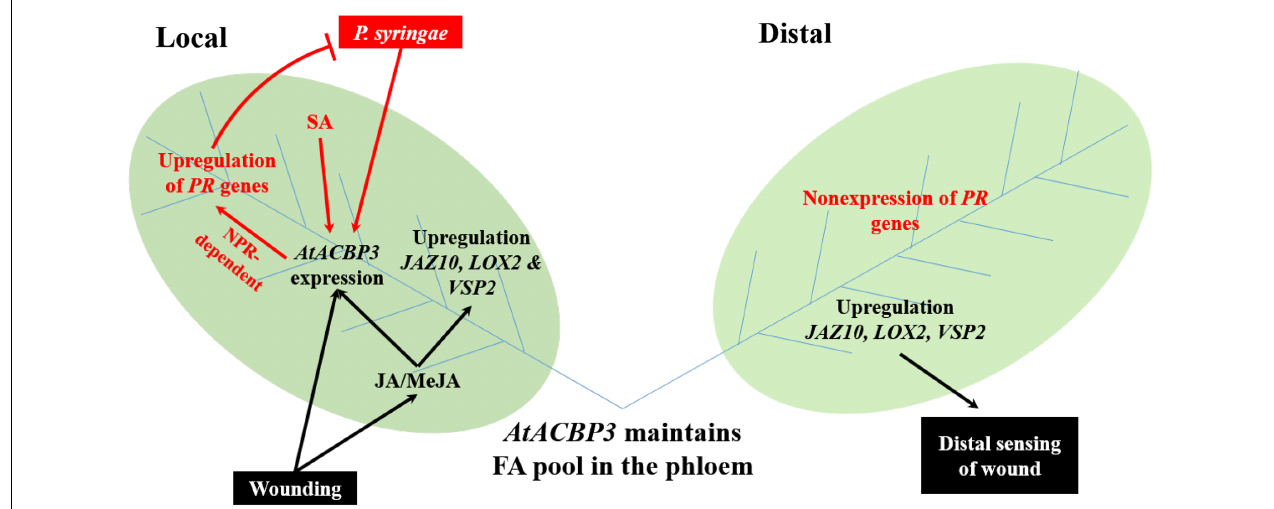
FIGURE 8 | A proposed model of AtACBP3 in plant stress responses was illustrated. Two leaves (labelled Local and Distal) are connected by vascular tissues which include phloem (blue lines) and xylem (not shown). Black colour scheme represents a JA-related pathway. Red colour scheme represents a SA-related pathway. ACC, 1-aminocyclopropane-1-carboxylic acid; AtACBP3, Arabidopsis thaliana ACYL-COA-BINDING PROTEIN3 ; JA, jasmonic acid; JAZ10, JASMONATE-ZIM-DOMAIN PROTEIN10; LOX2, LIPOXYGENASE2 ; MeJA, methyl jasmonate; NPR1, NONEXPRESSOR OF PR GENES1; PR genes, PATHOGENESIS-RELATED genes; SA, salicylic acid; VSP2, VEGETATIVE STORAGE PROTEIN2 .